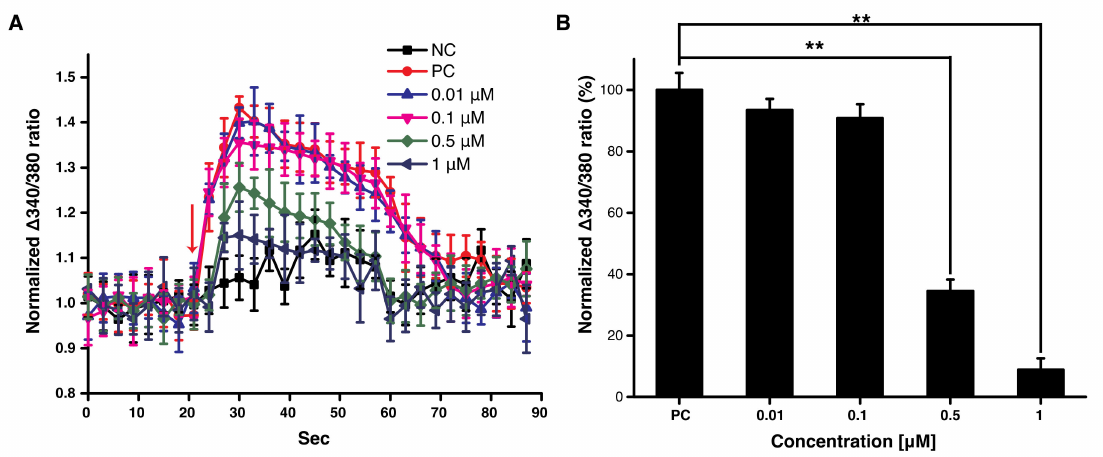
Figure 1. Intracellular Ca 2+ levels after decursin treatment in F11 cells in the presence of capsaicin. ( A ) Intracellular Ca 2+ levels after treatment with decursin every 3 s. The red arrow indicates the duration of treatment with capsaicin and decursin. NC: The negative control treated with DMSO only; PC: The positive control treated with 500 nM of capsaicin, without decursin. ( B ) Average intracellular Ca 2+ levels after treatment with decursin. The average was quantified from the normalized ∆ 340/380 ratio for 10 cycles after treatment with the decursin solution at the 10th cycle, as shown in (A). The normalized ∆ 340/380 ratio was calculated using the following formula: [ratio of fluorescence intensity at 510 nm (emission) to that at 340 nm (excitation)]/[ratio of fluorescence intensity at 510 nm (emission) to that at 380 nm (excitation)]. ** p < 0.01, assessed using paired t -tests. This experiment was conducted in